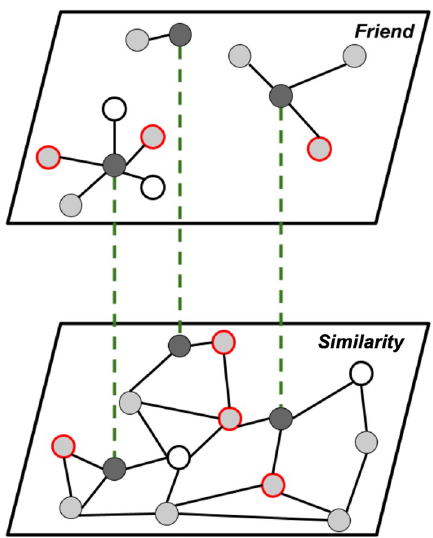
Fig. 3 The two layer network, with a similarity layer (bottom) and a friend layer (top). The dark gray nodes represent the players studied in this research. They exist in both layers